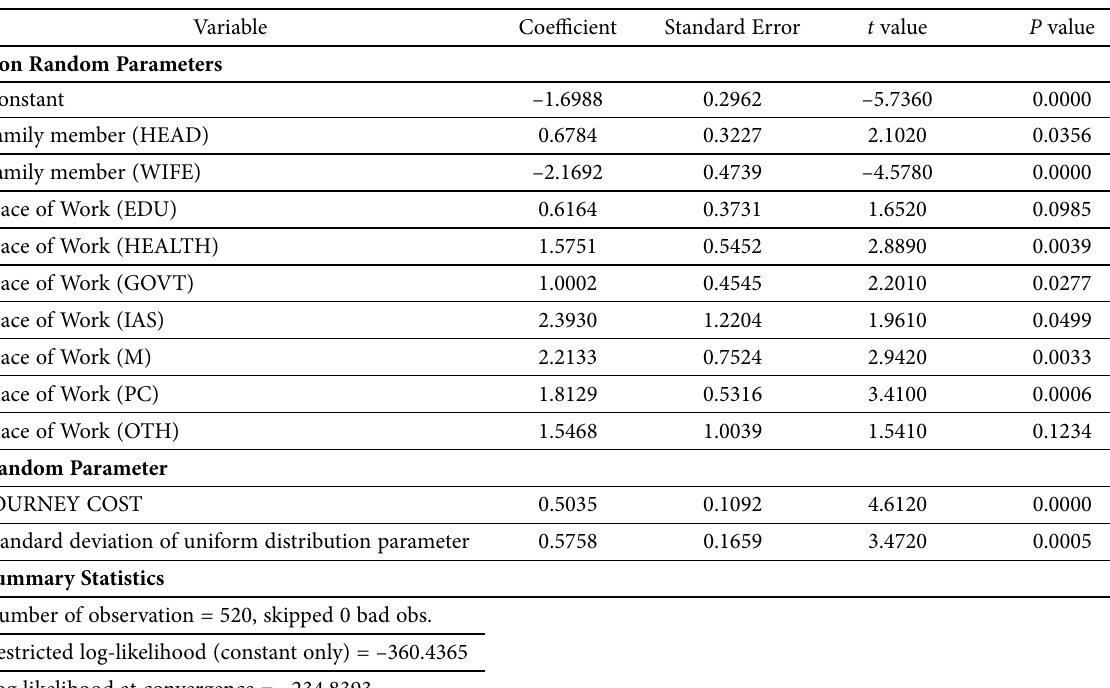
Table 5. Mixed logit model estimation results for ‘MALE